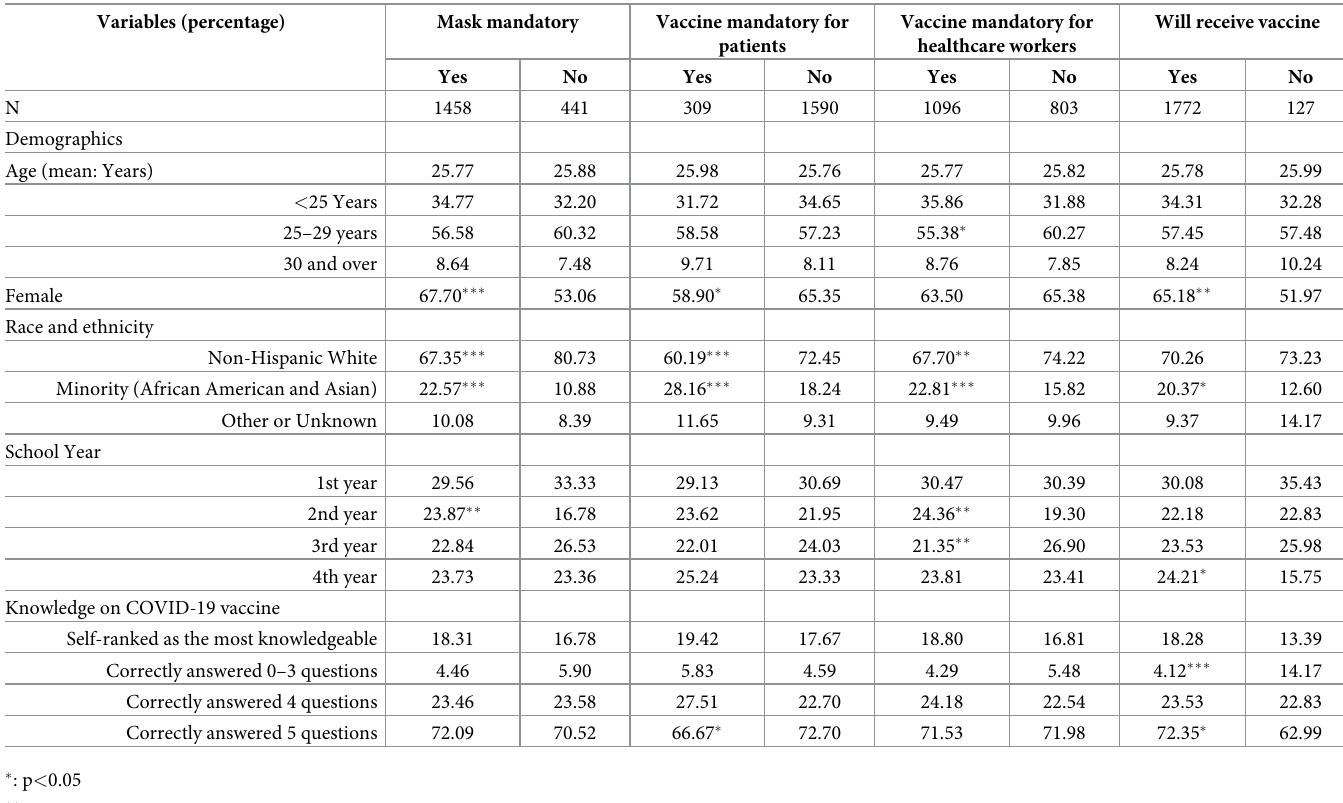
Table 2. Proportion of demographics and knowledge of the COVID-19 vaccine by attitude outcomes. Variables